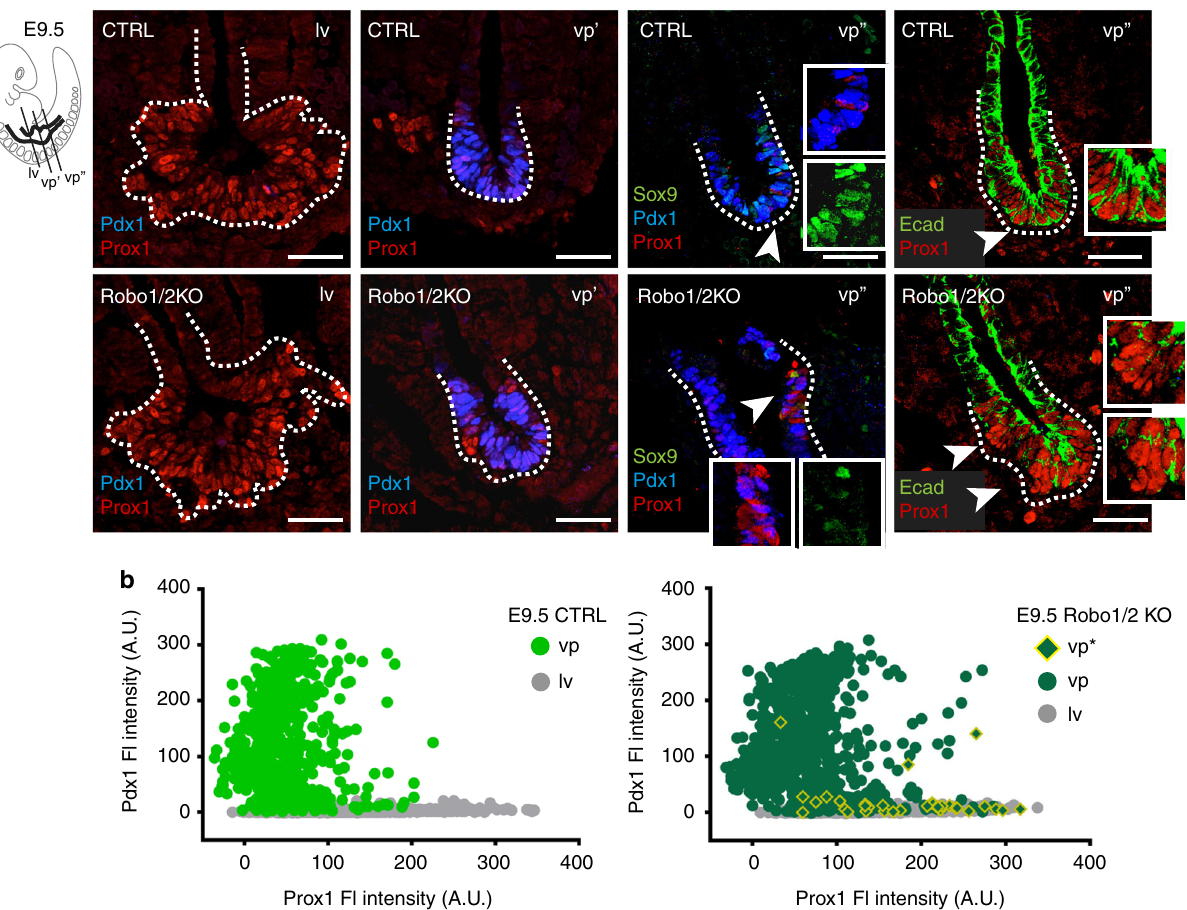
Fig. 2 Robo genes preserve pancreatic progenitor identity. a Representative IF images of E9.5 CTRL and Robo1/2 KO cryosections stained for Pdx1, Prox1, Sox9 and E-cadherin (Ecad). Consecutive liver (lv) and ventral pancreas (vp ’ , vp ” ) sections are shown. Liver (lv) cells are Prox1-positive ( + ), pancreatic progenitors (vp) are Prox1 + /Pdx1 + . Arrowheads indicate cells shown in white insets. Scale bars, 50 µ m. b Single-cell measurement of fl uorescence intensity of Prox1 and Pdx1 in liver buds (grey circle) and ventral pancreas of E9.5 CTRL (light green circle) and Robo1/2 KO (dark green circle) embryos. Diamond shapes indicate Robo1/2 KO ventral pancreatic cells that appear segregated from the surrounding epithelium and overlay with lv cells (grey). Fluorescence intensity was measured with Fiji and values corrected by linear normalisation within each embryo. FI fl uorescence intensity, AU arbitrary units; n = 3 per